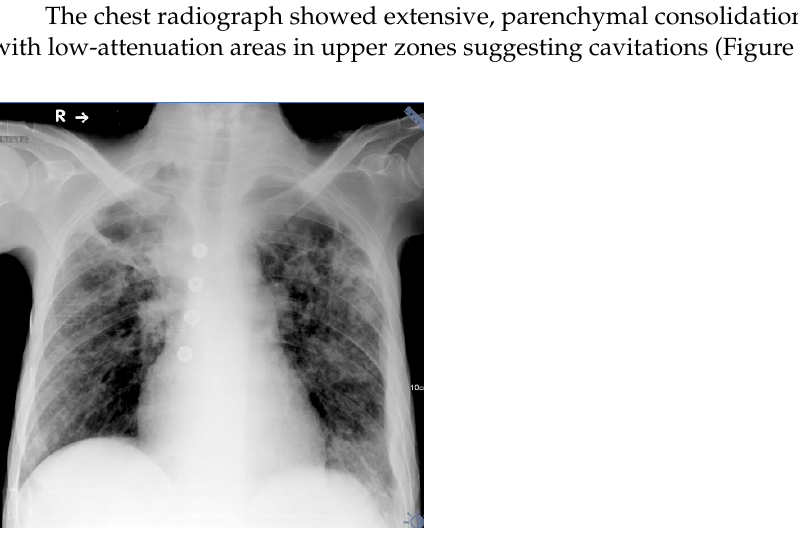
Figure 2. Chest X ‐ ray anteroposterior in a horizontal position. Extensive, parenchymal consolida ‐ Figure 2. Chest X-ray anteroposterior in a horizontal position. Extensive, parenchymal consolidations tions in both lungs with low ‐ attenuation areas in upper zones suggest cavitations. in both lungs with low-attenuation areas in upper zones suggest